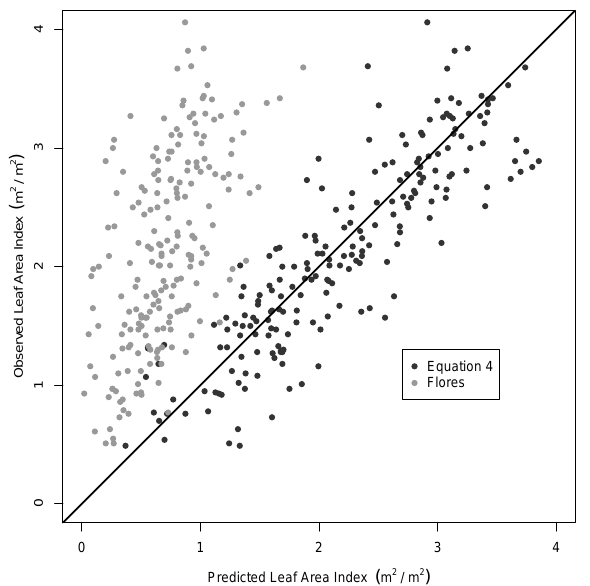
Figure 7. Predicted vs. measured leaf area index from the SIMEX bias-corrected model (Equation (4)) and a comparison to the Flores et al. top of atmosphere model predictions